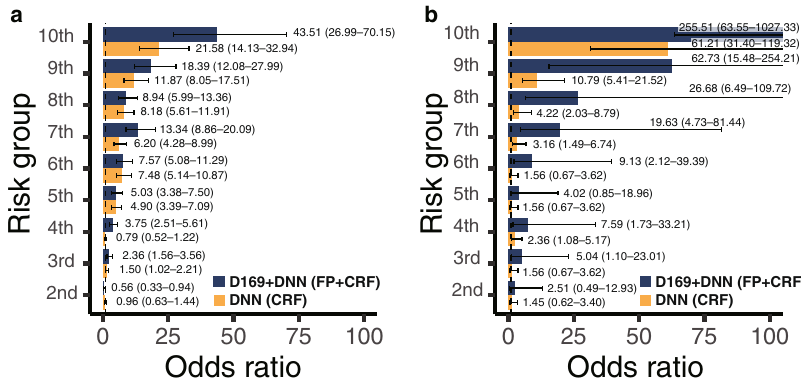
Fig. 3 Risk gradient for CVD according to the risk group. Odds ratios with 95% con fi dence interval (error bar) according to the risk groups in comparison to the lowest risk group in the internal validation set ( a ) and external validation set ( b ). D169 + DNN and DNN are identical in Model 5 and Model 3 in Table 2, respectively. CVD cardiovascular disease, D169 DenseNet-169, DNN deep neural network, FP fundus photographs, CRF clinical risk factors.